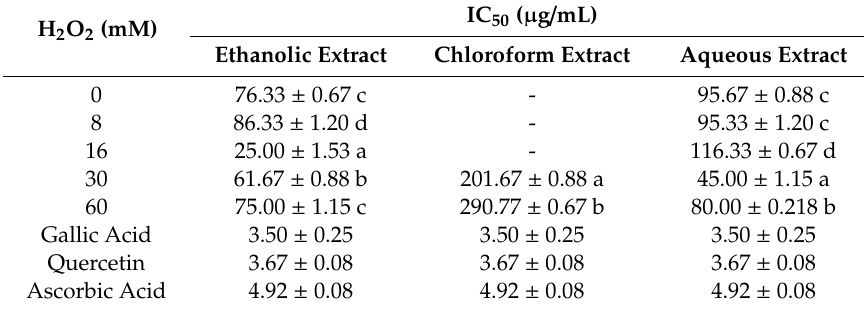
Table 2. The IC 50 ( µ g / mL) e ff ect of di ff erent treatments of H 2 O 2 on DPPH • scavenging activity of di ff erent extract of Ficus deltoidea plant leaf. Means ( ± S.E.) with same letter do not di ff er significantly according to She ff er’s post hoc test at α =